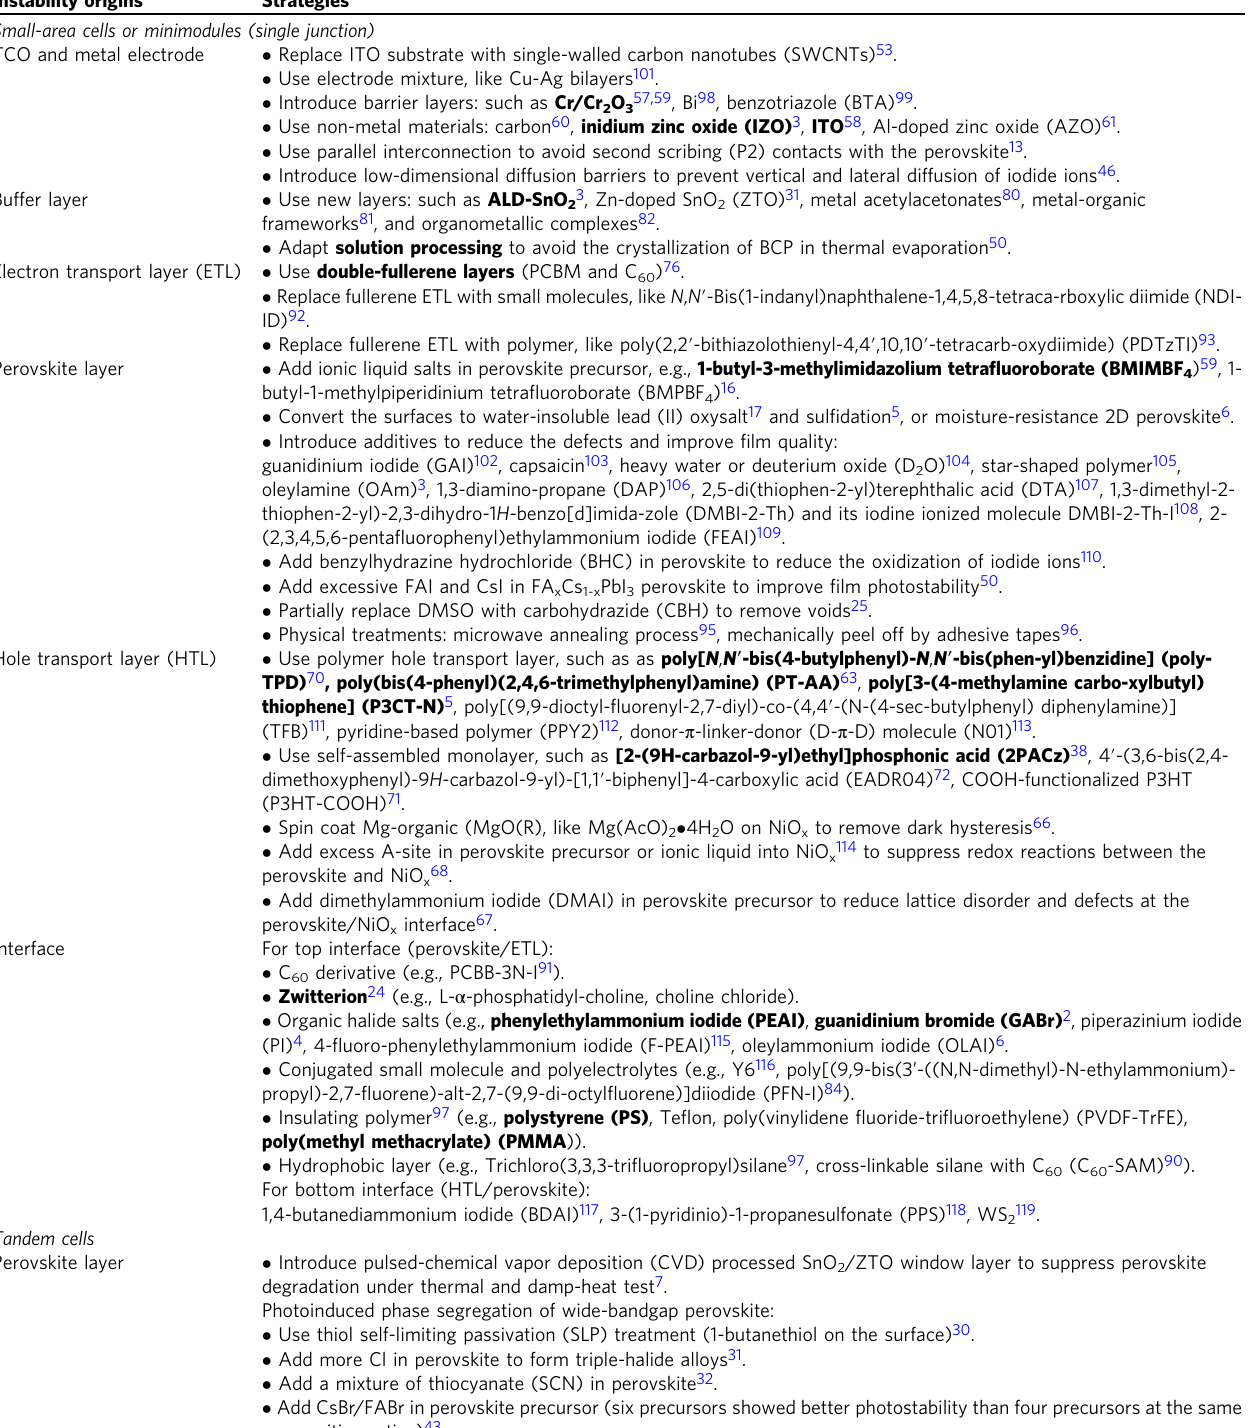
The highlighted chemicals or methods (bold font) in the strategies have a wider report or adoption in the IPSC